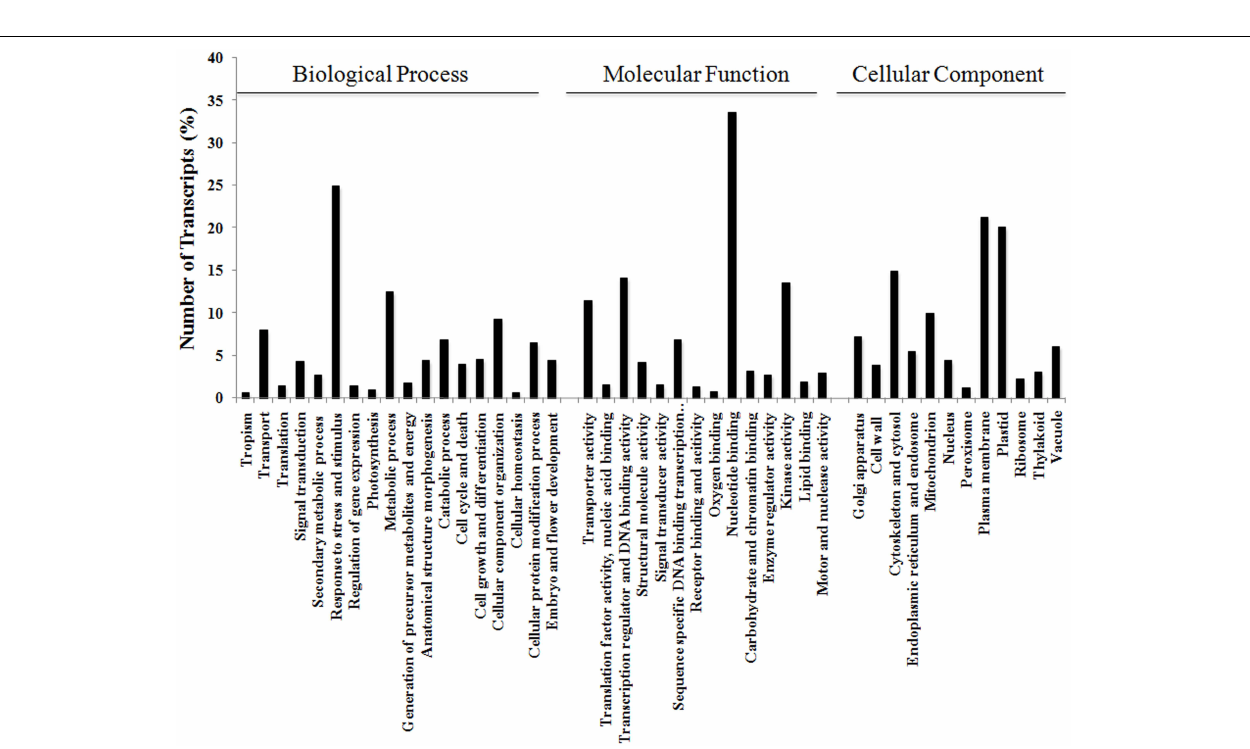
FIGURE 3 | Functional annotation of V. faba contigs. Blast2GO characterization of GO terms in the three categories of Biological Process, Molecular Function, and Cellular Component.